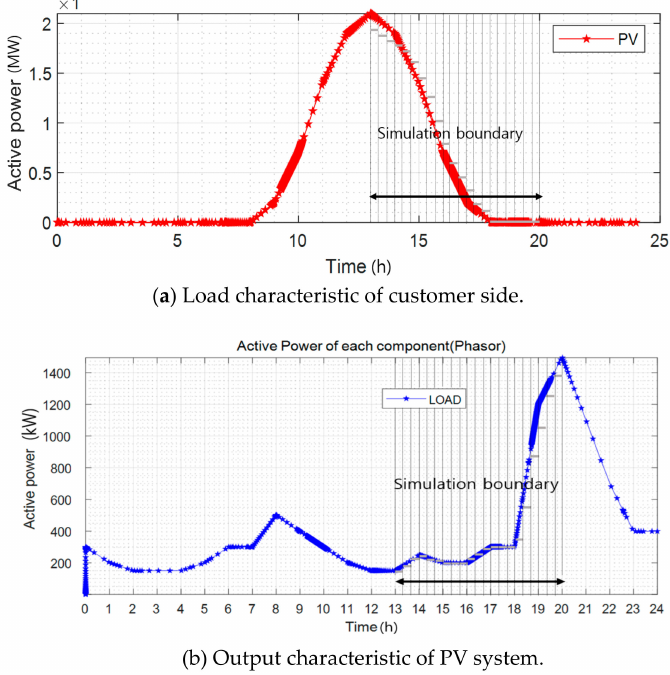
Figure 15. Output pattern of the PV system and